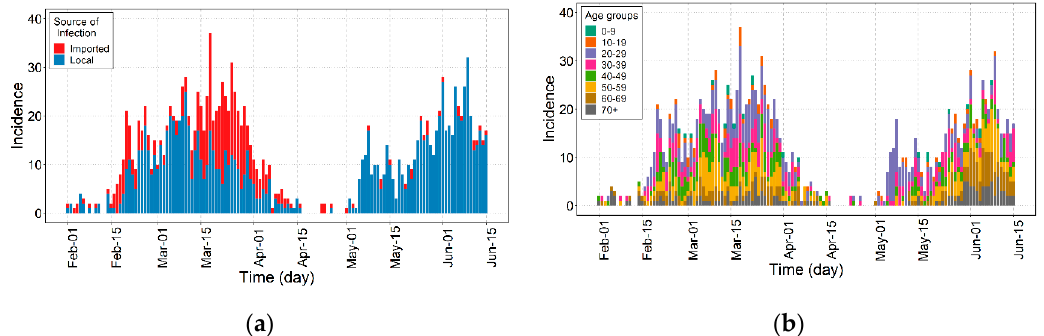
Figure 1. Epidemic curve of confirmed cases of COVID-19 in Seoul and Gyeonggi province, Korea by ( a ) source of infection for the imported (red) and local (blue) cases and ( b ) by age group. Table 1. Population summary of the cumulative incidence of COVID-19 by age group in Seoul and